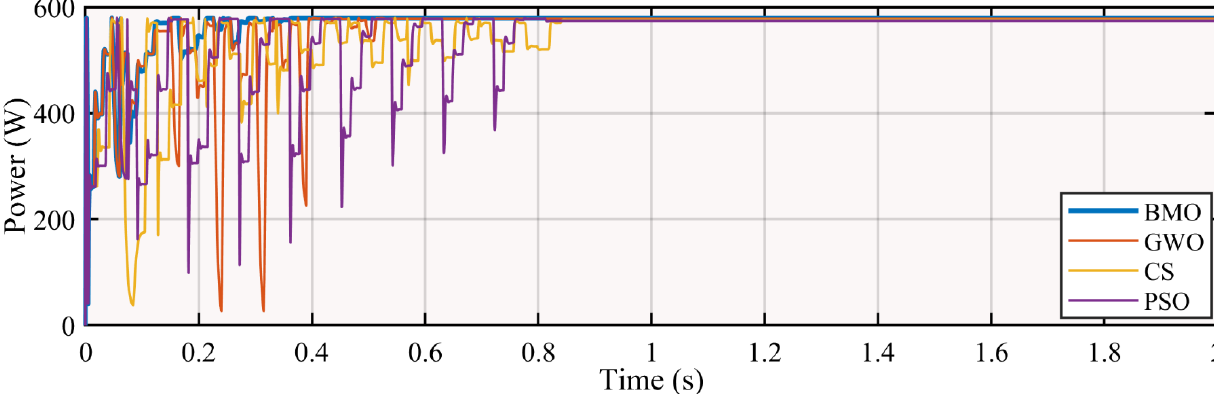
Figure 7. Competing techniques Power Case-1.